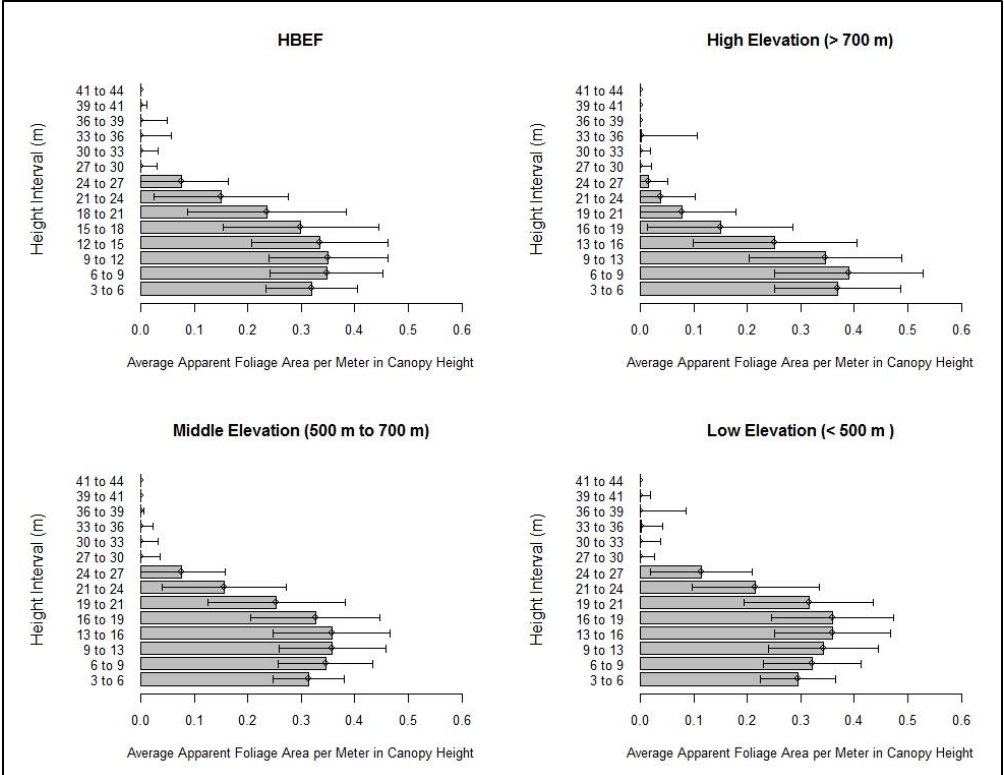
Figure 5. The apparent average foliage area profile for HBEF, divided into 3 m height intervals. The top-left graph shows the foliage profile averaged over all of HBEF. The error bars depict the standard deviation of foliage profile measurements for each of the height intervals. The averaged foliage profile for low elevations shows that the amount of foliage peaks between 13 and 19 m in the canopy. This peak in foliage area is lower for canopies at middle (9 to 16 m) and low (6 to 9 m)